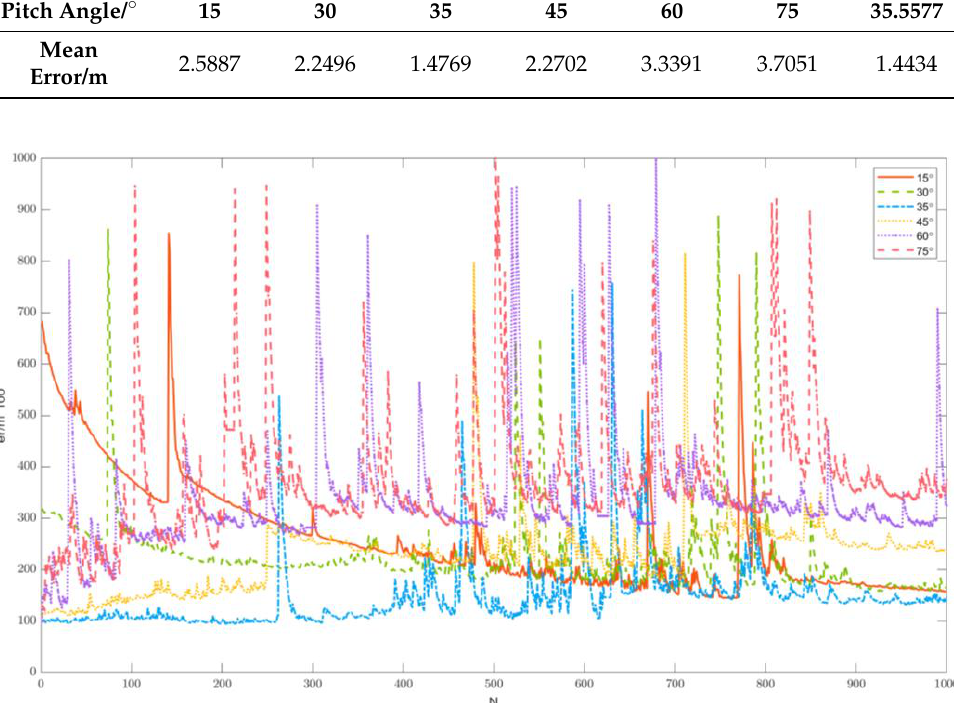
Figure 5. Schematic diagram of multi-stations positioning deployment.